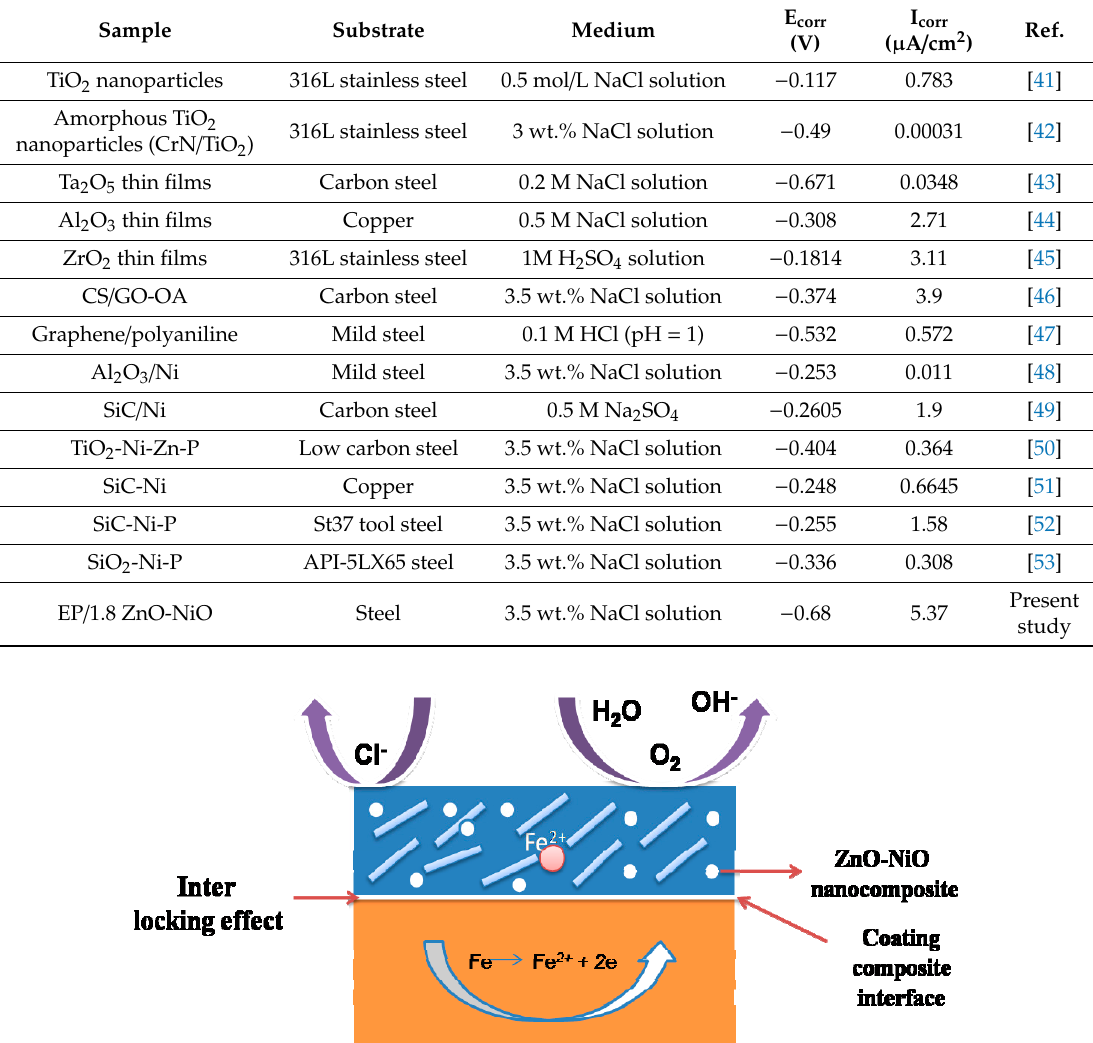
Table 3. Comparison of the corrosion parameters of di ff erent nanomaterial coatings.